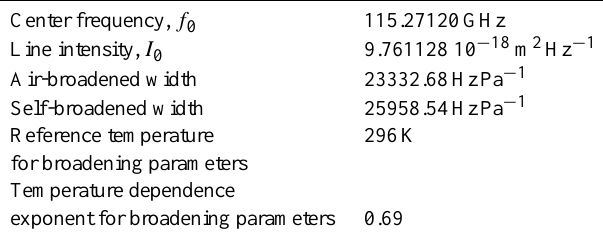
Table 2. Some of the used CO spectroscopic